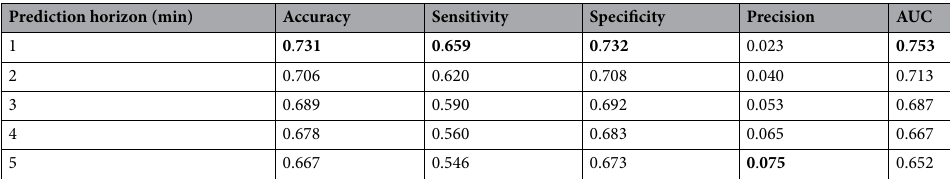
Table 1. Here, we present results to compare prediction performance for different lengths of time intervals when predicting flux increases. Values in bold indicate the best score for the same indicator. With the exception of the precision metric, performance improved as the prediction time becomes shorter. We confirmed statistically significant differences in terms of AUC using t -tests among all problem settings.